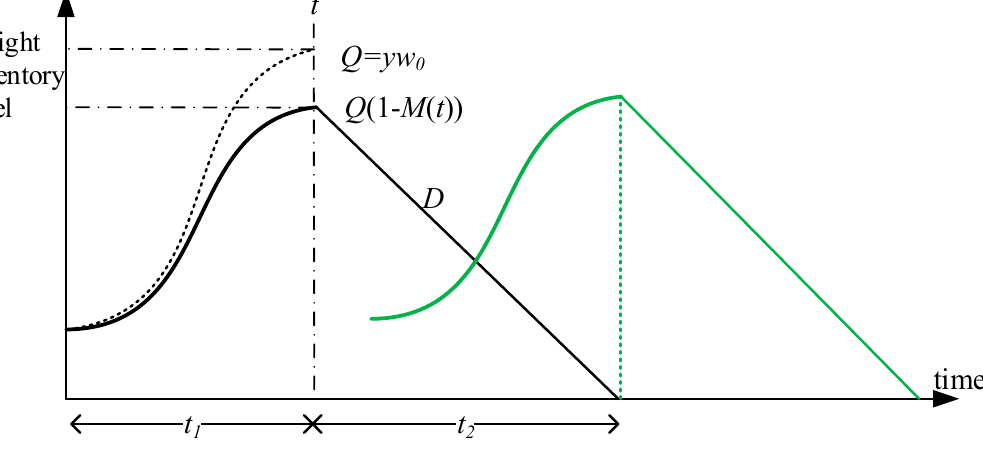
Figure 1. The weight inventory level graph of growing items.